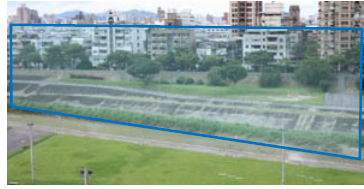
Figure 2. Oblique view of research